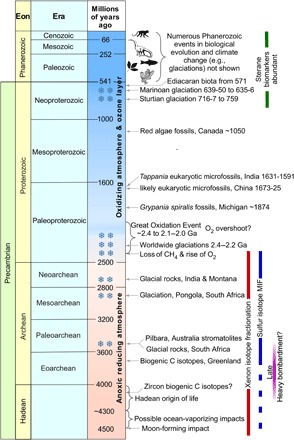
Precambrian events and atmospheric change.For biological evolutionary dates, see (6). For a description of other events, see (64) and references therein.